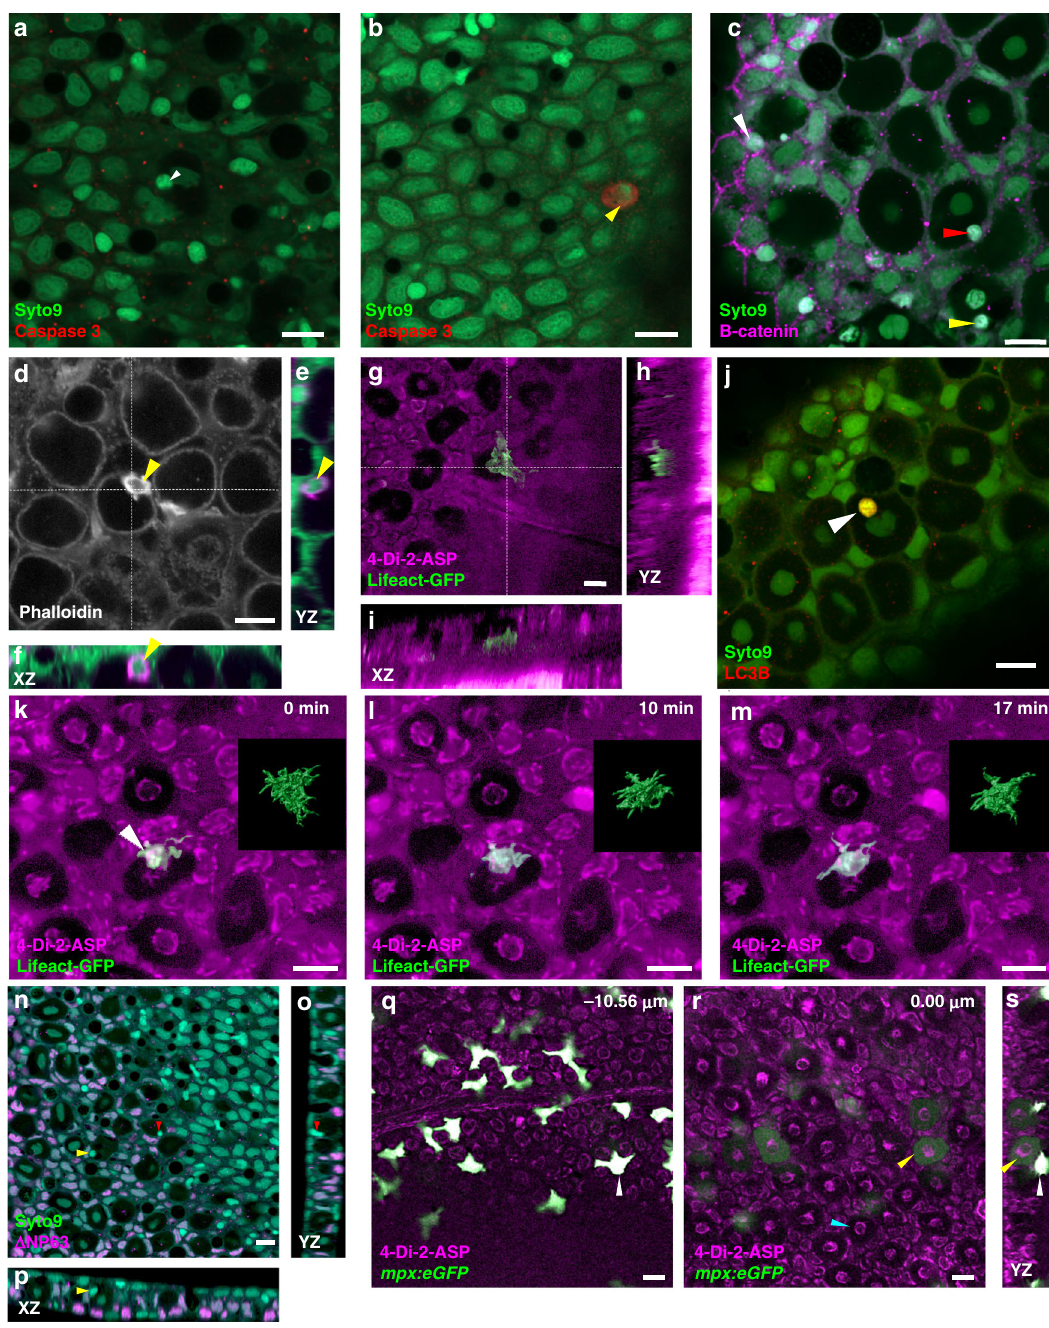
Fig. 2 Characterization of cell invasion in zebra fi sh skin. a , b Labeling for cleaved Caspase-3. a The second cell within a club cell (white arrowhead) is unlabelled. b An example of a labeled skin cell (yellow arrowhead). c Label for β -catenin. In contrast to super fi cial epithelial cells, which have an enrichment of β -catenin at the periphery (white arrowhead), no enrichment is detectable in cells entering (red arrowhead) or within (yellow arrowhead) club cells. d Phalloidin label for f-actin. A strongly labeled cell (yellow arrowhead) is visible at the edge of a club cell. e , f Transverse sections through cell in d , showing the peripheral position of the cell relative to the club cell. g A fi sh expressing Lifeact-GFP in a motile cell that appears to be extending a protrusion into a club cell. h , i Transverse sections through the center of the club cell. The skin was labeled with 4-Di-2-ASP, which leaves most the club cell cytoplasm unlabelled. The invading cell is located near the base of the epithelium. j Label for LC3B is detected within the second cell (white arrowhead), but not surrounding it. k – m Three different time points of the skin of a fi sh expressing Lifeact-GFP in cell that appears to be mostly inside a club cell (arrowhead), but with protrusions extending outside. The insets show surface rendering of the green fl uorescence across the z -stack. The cell changes shape over the period of imaging. n – p Label for Δ Np63 (magenta). No signal was detected in cells invading club cells (yellow and red arrowheads). q , r Two different focal planes of a fi sh with neutrophils expressing GFP under the control of the mpx promoter. Neutrophils are strongly fl uorescent. The cytoplasm of a subset of club cells is weakly labeled; the cyan arrowhead indicates an unlabelled club cell. s Transverse section through a labeled club cell (yellow arrowhead) and neutrophil (white arrowhead). Scale bar = 10 µ